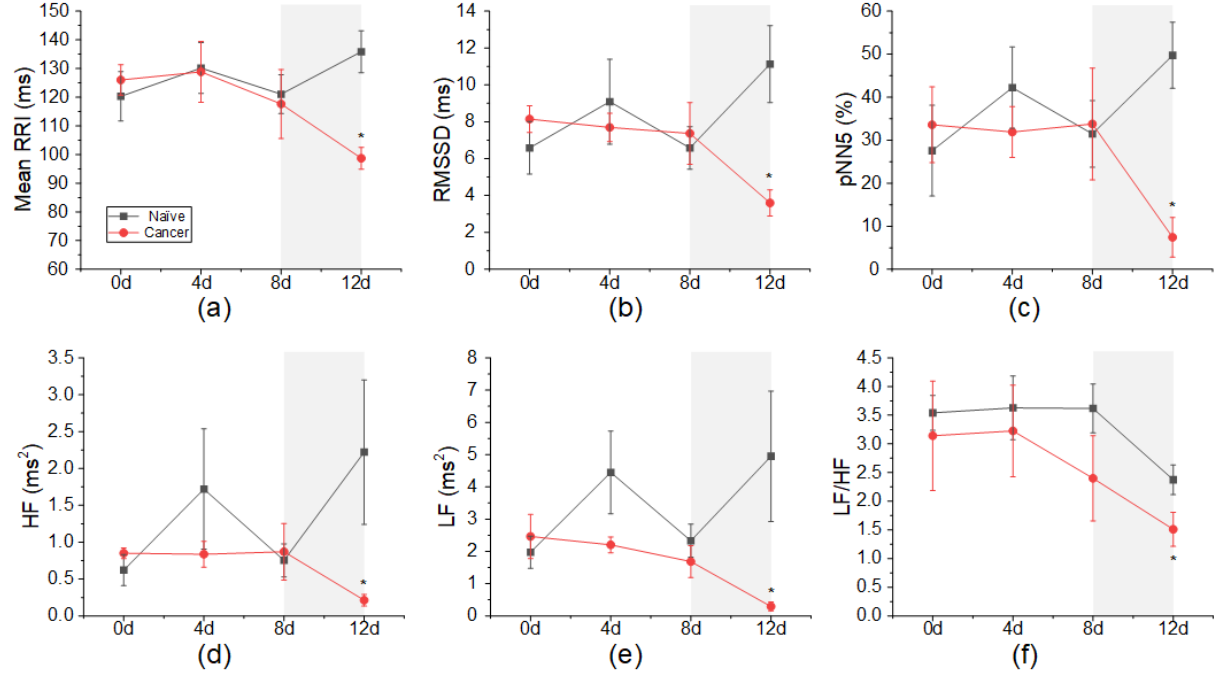
Figure 3. Effects of cancer pain on heart rate variability parameters. ( a ) MeanRRI. ( b ) RMSSD. ( c ) pNN5. ( d ) HF. ( e ) LF. ( f ) LF/HF. All HRV parameters in the cancer group were similar to those in